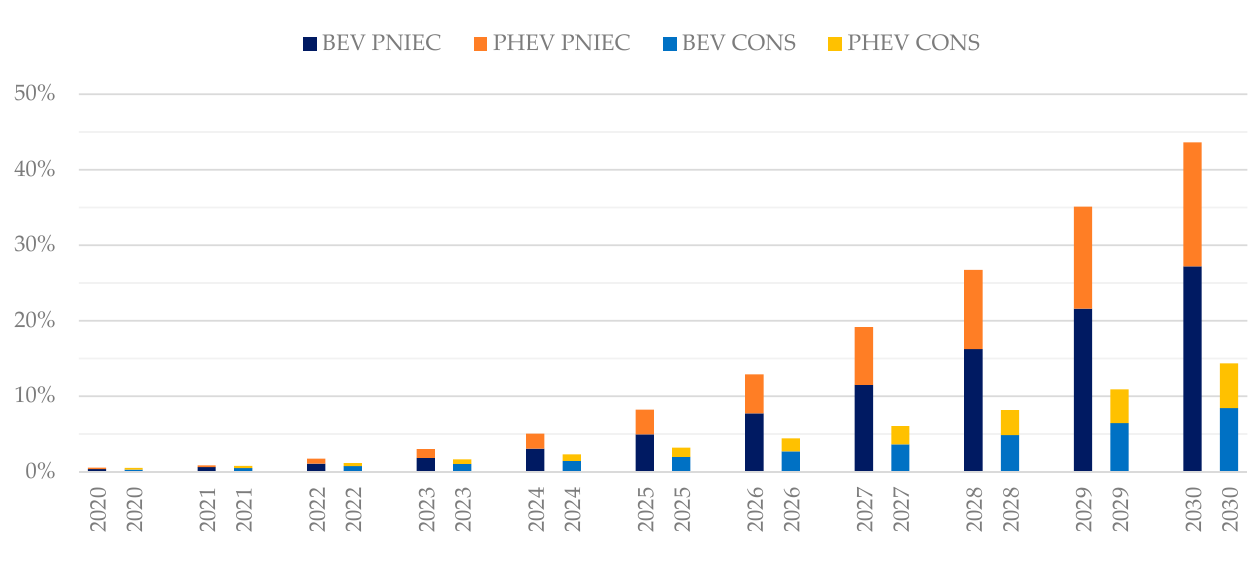
Figure 15. EV penetration index forecast for Rome–Fiumicino airport for private cars.